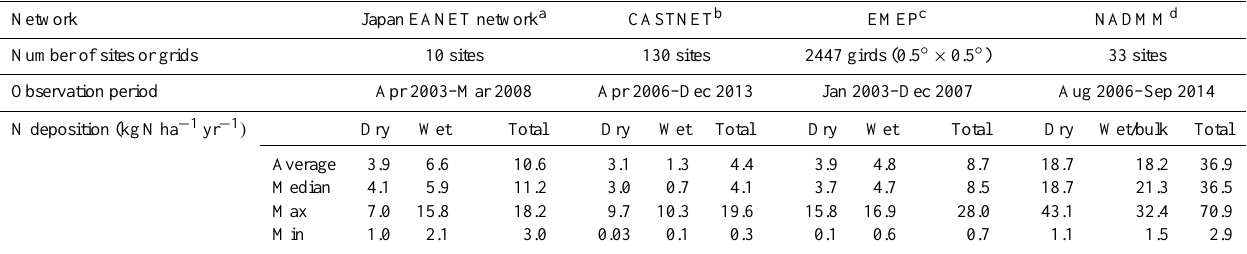
Table 1. Comparison of dry, wet (wet/bulk), and total deposition fluxes of N r compounds between NNDMN in China and three networks in other